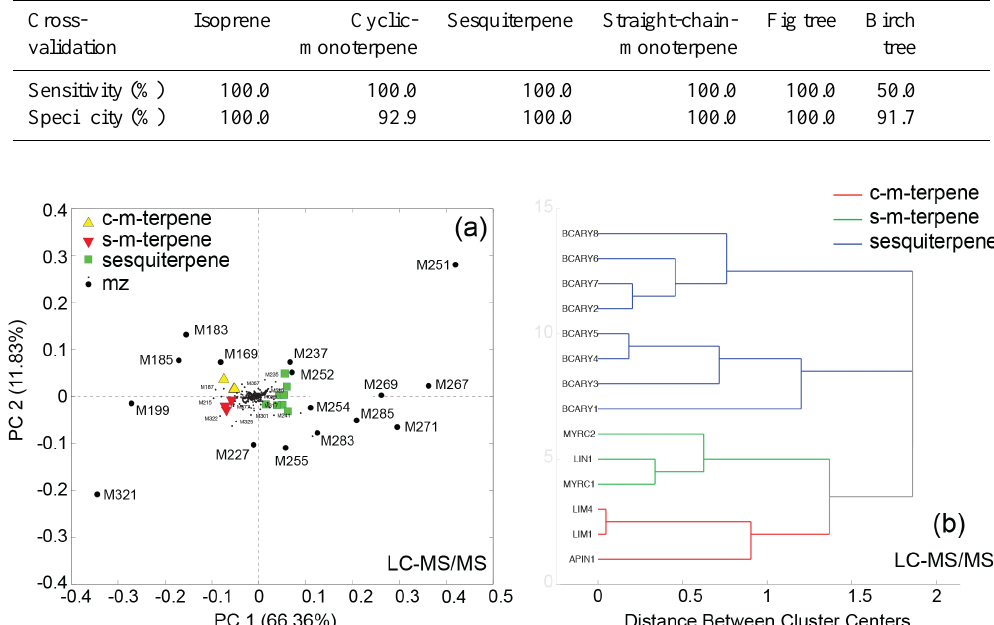
Figure 7. (a) Loadings bi-plot of the second vs. first principal components obtained from the PCA of LC-MS/MS aerosol spectra from a subset of terpene experiments and (b) the corresponding HCA dendrogram. See main text (Sect. 4.5 and Table 3) for further information, including ion